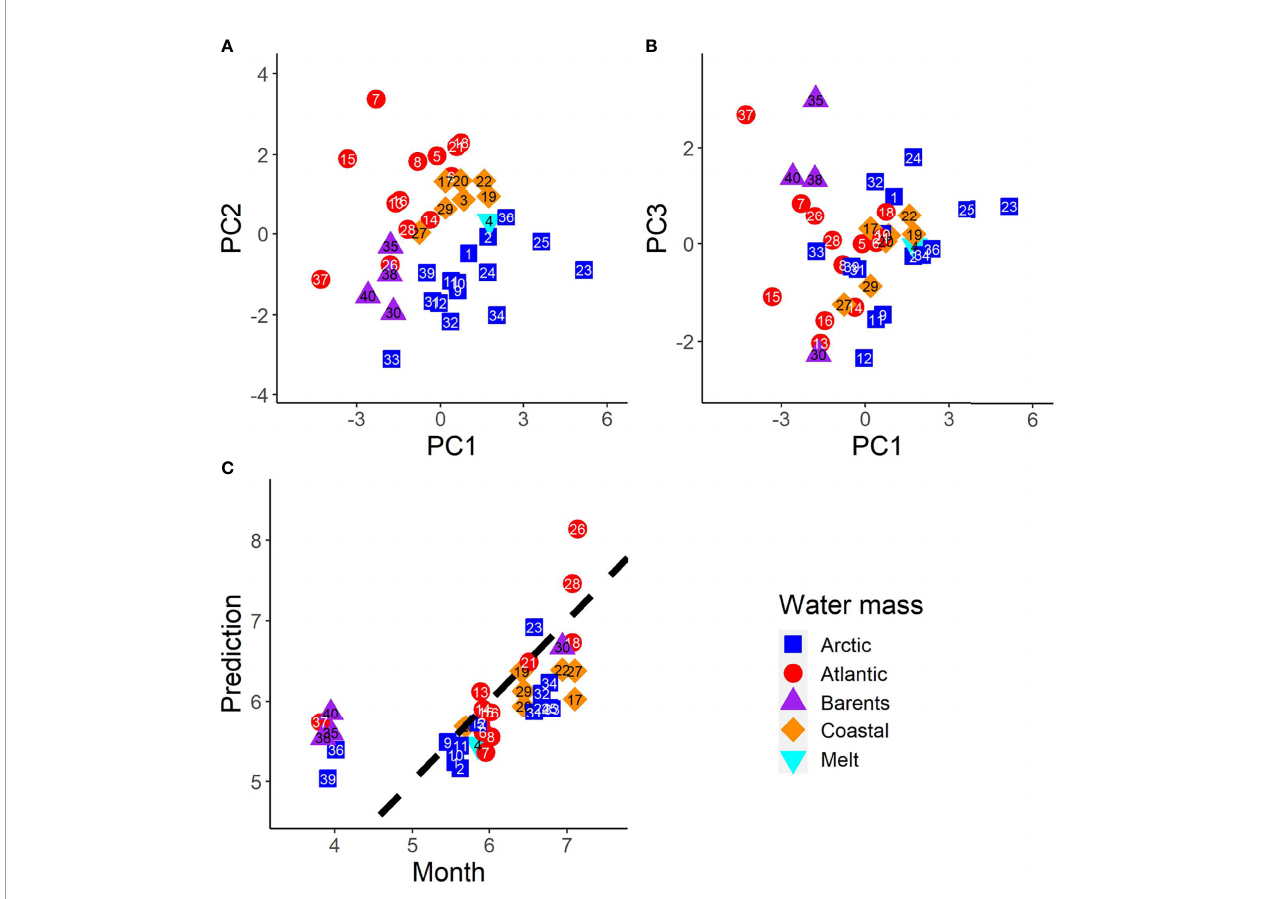
FIGURE 5 | (A) PC1-2 space of environmental variables, showing clear evidence of clustering by water mass. (B) PC1-3 space of environmental variables. (C) Month of sampling, compared to prediction derived from linear additive model of PC5-6. A dashed line marks a 1:1 slope. Samples are identi fi ed by unique